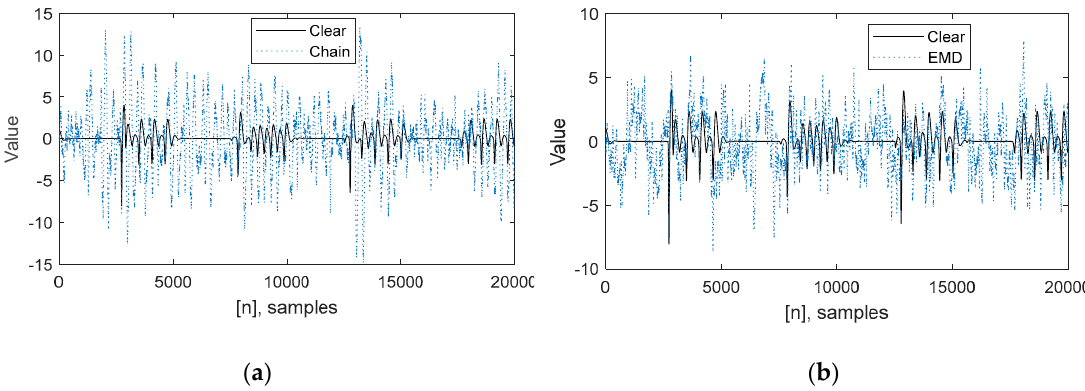
Figure 12. Recovering of master-slave synchronization error at SNR = − 10 dB using chain of driven oscillators denoising ( a ) and EMD filtration ( b ).